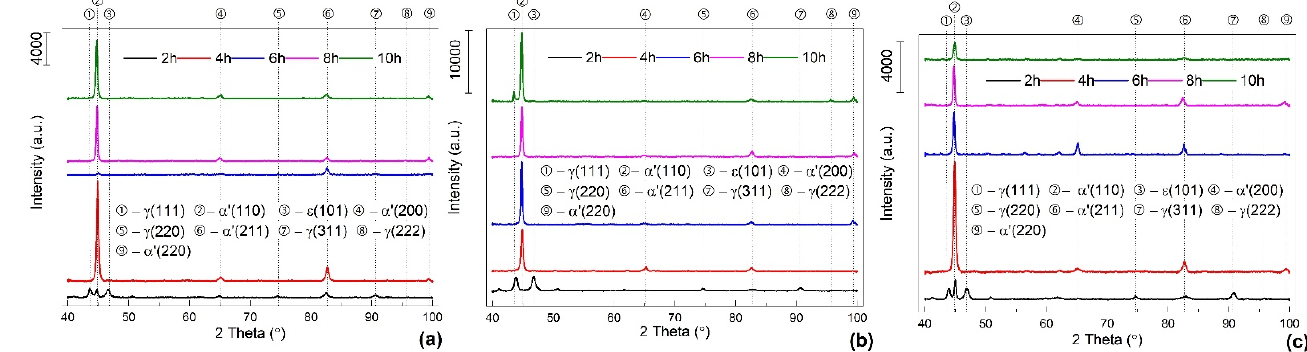
Figure 7. Typical XRD pa tt erns of solution-treated specimens after the application of DMA-SS-3PB with di ff erent frequencies: ( a ) 1 Hz; ( b ) 5 Hz; and ( c ) 10